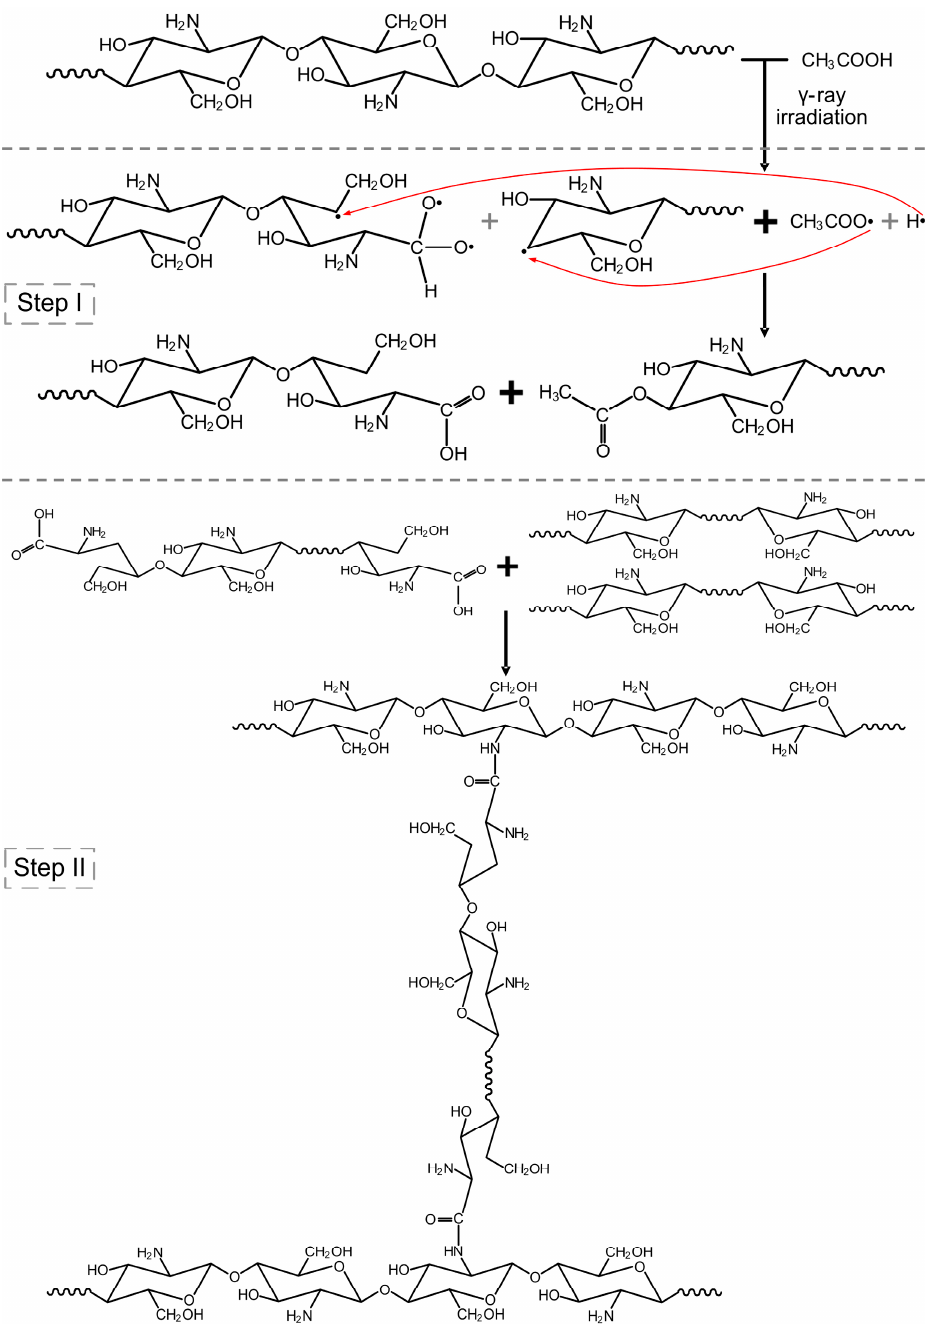
Figure 1. Schematic illustration of the potential mechanism of irradiation crosslinking reaction of composite films with the existence of acetic acid.